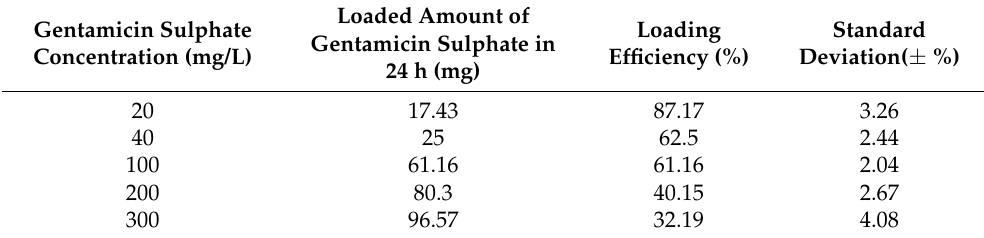
Table 2. Drug loading performance of hydrogel film in different concentrations. Loaded Amount of Gentamicin Sulphate Gentamicin Sulphate Concentration (mg/L)